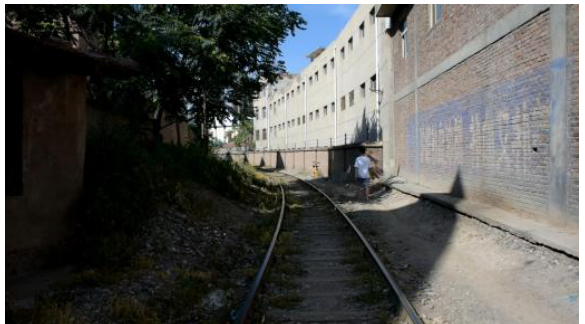
Fig. 5. The original image of the 335 th frame of video 1